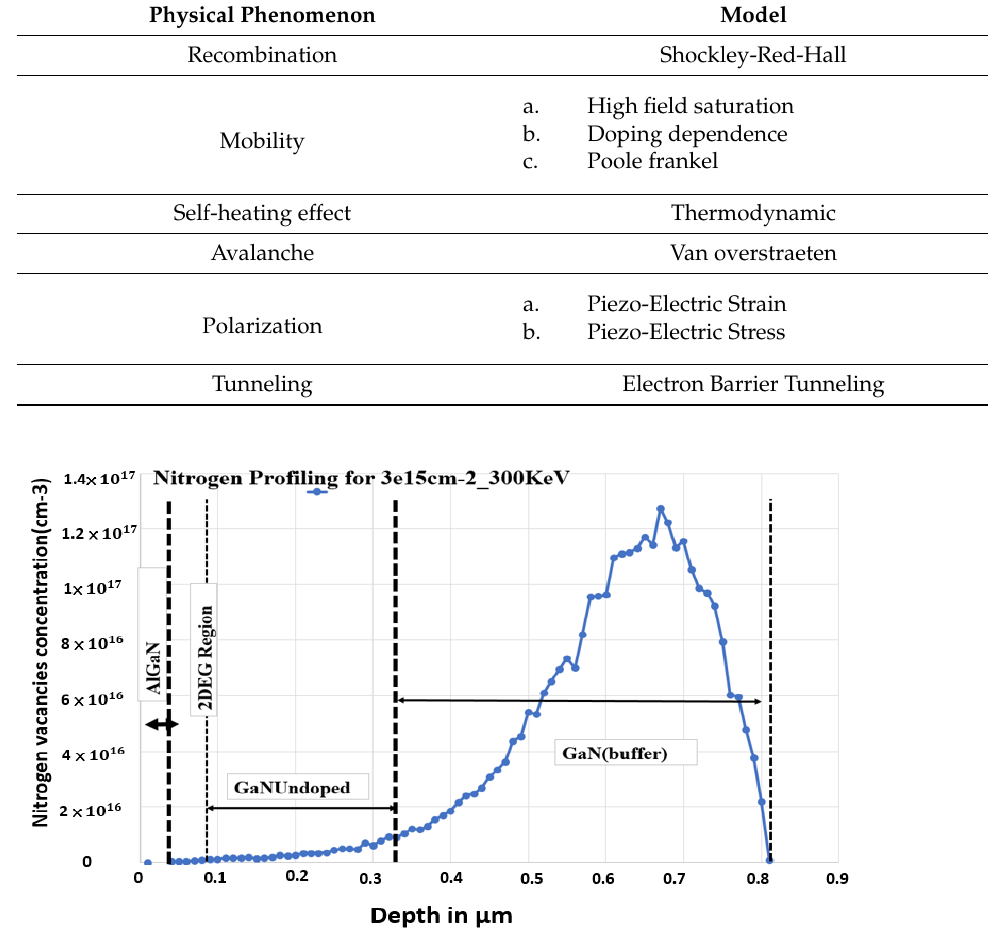
Figure 3. The depth profile of the nitrogen vacancies created by 300 KeV energy carried out by using TRIM simulation.